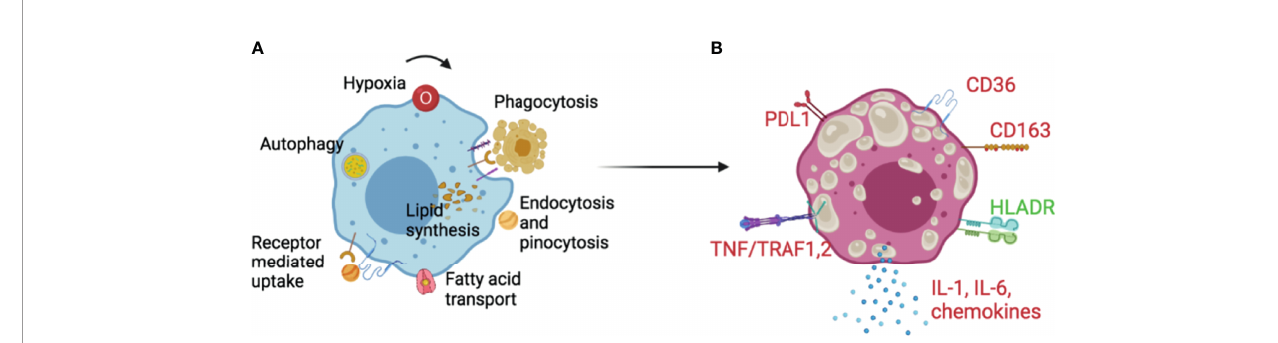
FIGURE 1 | Foam cells in TB. (A) Lipid droplet synthesis in macrophages can be triggered by external and internal stimuli. Extrinsic complex sources of lipids include phagocytosis of apoptotic or necrotic cells, or endocytosis, pinocytosis and receptor mediated uptake of lipoproteins. Simpler fatty acids can be transported by specialised machineries in the cell. Lysosomal activity and autophagy contribute to the degradation of accumulated lipid remnants in the cell to avoid lipotoxicity. Cytokines, hormones, growth factors and metabolic changes such as variations of glucose level, induce enzymes and proteins important for lipid synthesis and droplet stability. (B) Although there is no consensus, some markers appear repeatedly in Foam cell literature. Foam cells have been shown to have increased scavenger receptors- CD36, CD163, TNF- a /TRAF1,2, the in fl ammatory cytokine IL-6 and the in fl ammasome dependent IL-1 b . The checkpoint inhibitor PDL1 has been shown as increased while the antigen presentation related HLA-DR as decreased. Upregulated markers are colour coded in red and downregulated in green. These and other markers can guide needed translational histological studies on foam cells in multiple species and cell line models. It is early to ascertain the true nature of foam cells in TB, and more research in primary models is necessary since THP1 and primary macrophages behave differently. See text for